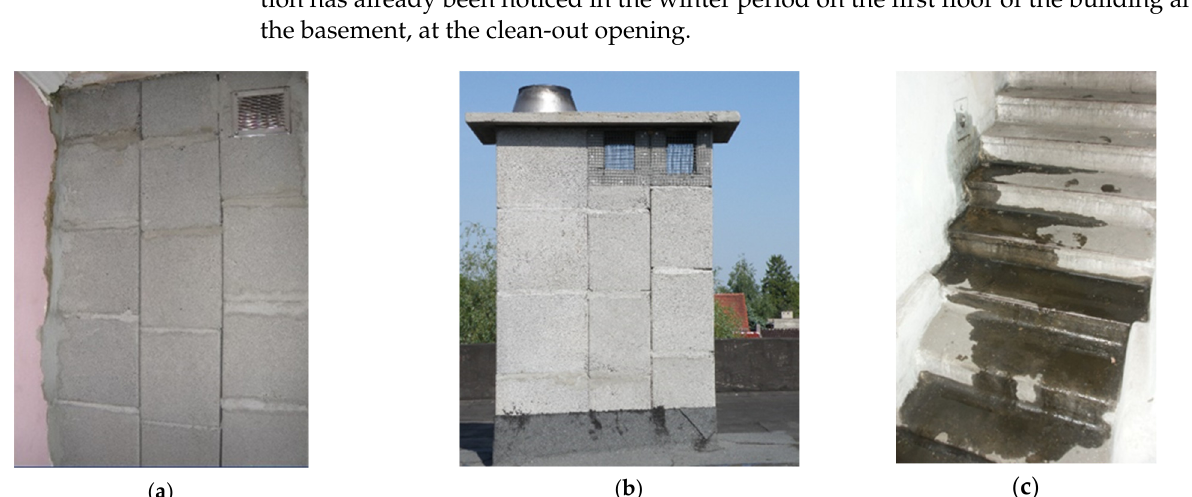
Figure 7. Thermal ( a ), and visible light ( b ) images of the chimney wall in the attic space (at the inspection grille).